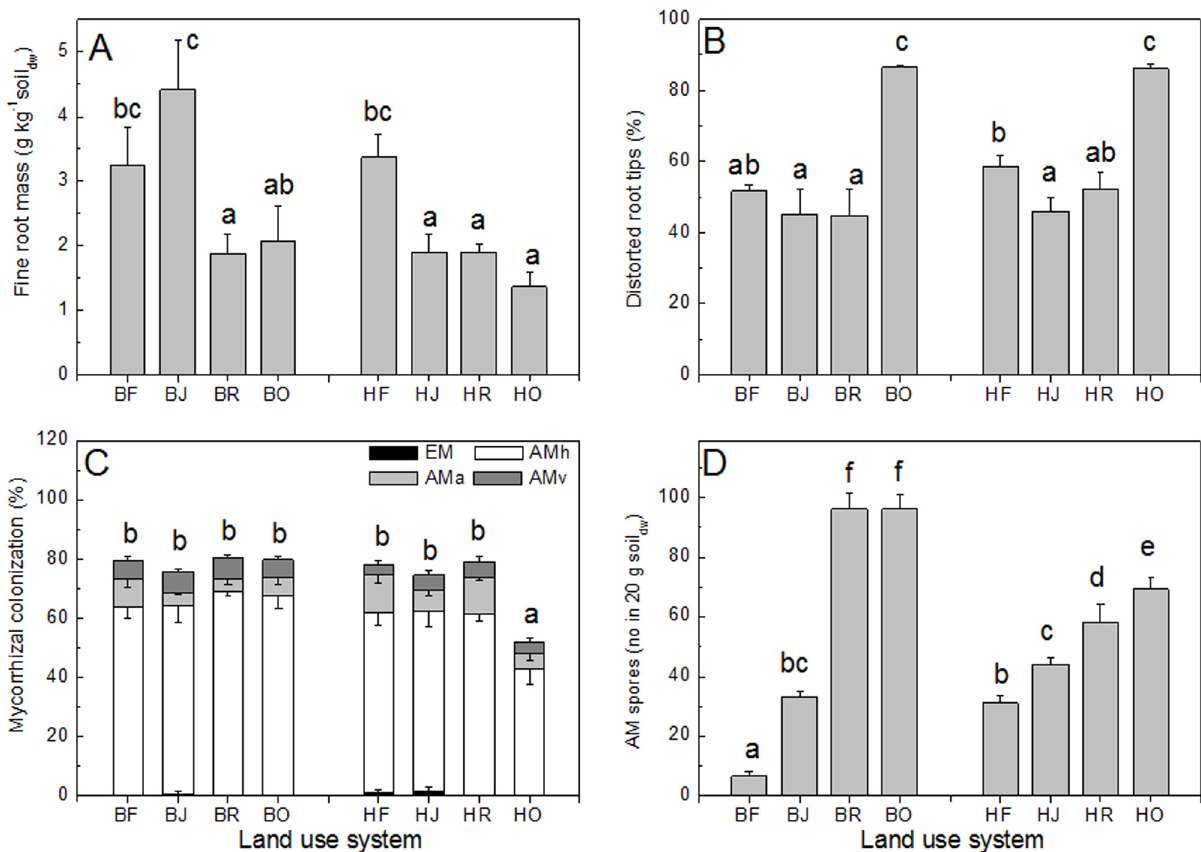
Fig 3. Performance parameters of roots in different land use systems. (A) Fine root mass to a depth of 0.2 m, (B) Fraction of distorted root tips (100% is the total number of inspected root tips), (C) Fraction of the inspected root lengths colonized with mycorrhizal hyphae (AMh), arbuscules (AMa), vesicles (AMv) and fraction of vital root tips colonized with ectomycorrhizas (EM), (D) Number of arbuscular mycorrhizal spores. Data indicate means ( ± SE). Different letters indicate significant differences at P < 0.05. B = Bukit 12, H = Harapan, O = oil palm, R = rubber plantation, J = jungle rubber, F = forest.